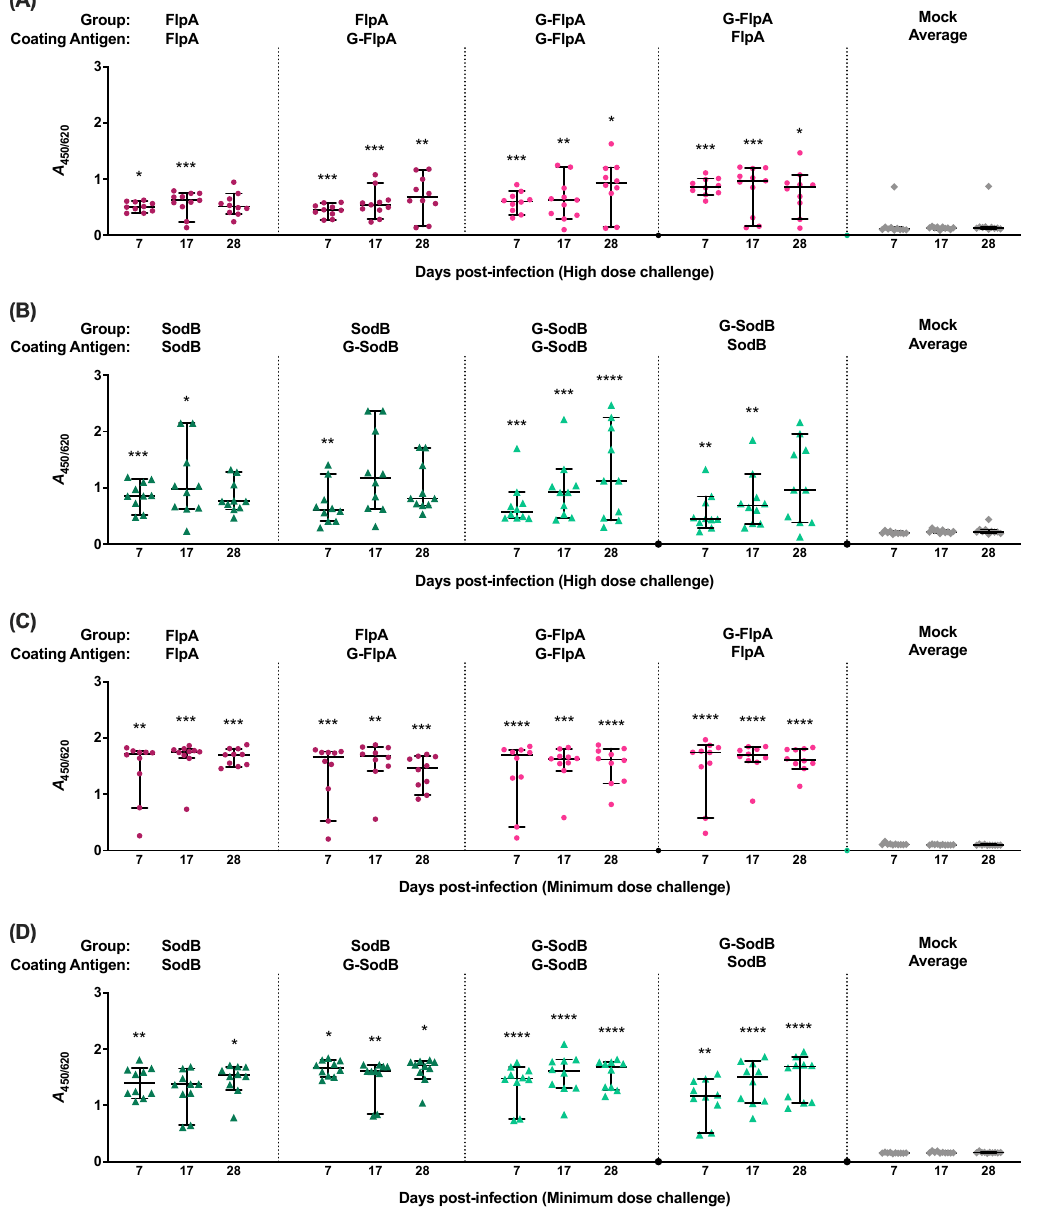
Figure 4. Induction of humoral immune responses. Levels of serum IgY against the administered vaccine antigens were determined in chickens vaccinated with FlpA ( • ), G-FlpA ( • ), SodB ( (cid:78) ), G-SodB ( (cid:78) ) or PBS (mock-vaccinated, (cid:7) ) at all the time points post-infection. High levels of antigen-specific IgY were found in all vaccinated birds groups compared to mock-vaccinated chickens. This was observed in both the high dose challenge trial ( A , B ) as well as the minimum dose challenge ( C , D ), although antibody levels were higher in the latter trial. Antibody levels did not have an impact on caecal colonisation levels. Statistically significant P values of ≤ 0.05 compared to the mock-vaccinated group are indicated by asterisks. No di ff erences in serum IgY levels were found between groups vaccinated with glycosylated and unglycosylated vaccine